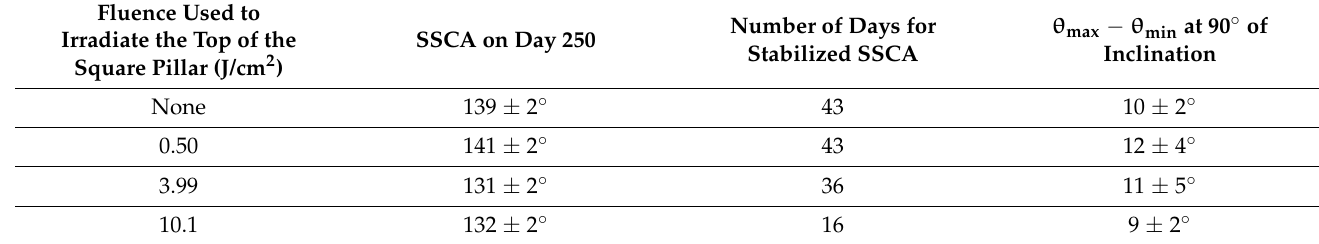
Table 1. Wetting measurement results for the samples textured in ambient air.